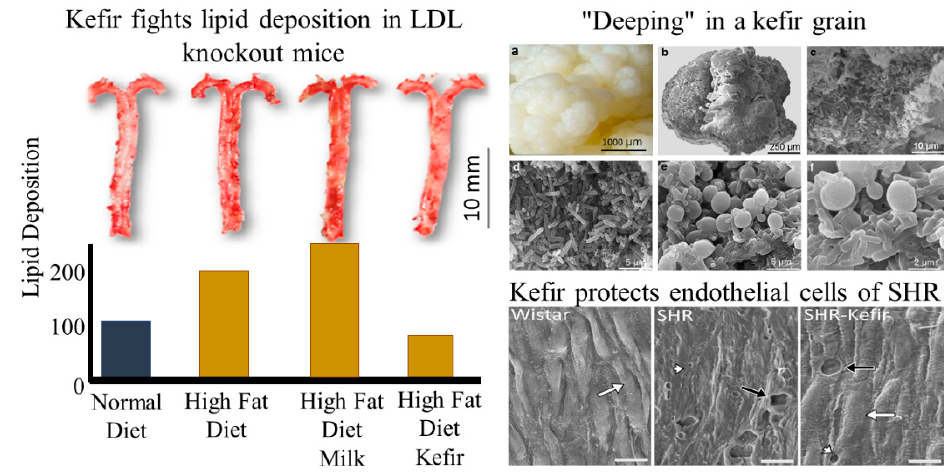
Figure 4. Illustrative images from our laboratory demonstrating the vascular protective role of kefir in both lipid deposition (in LDLr knockout mice) and in the endothelial layer (in SHR model). The images were reconstructed and modified from previous publications [7,80]. In addition, we demonstrate the “inside world” of a single grain, which was pictured at increasing magnifications (from “b” to “f”) and symbiotically inhabited by millions of microorganisms that our laboratory has used to demonstrate the effect of kefir experimental and clinical studies [7].